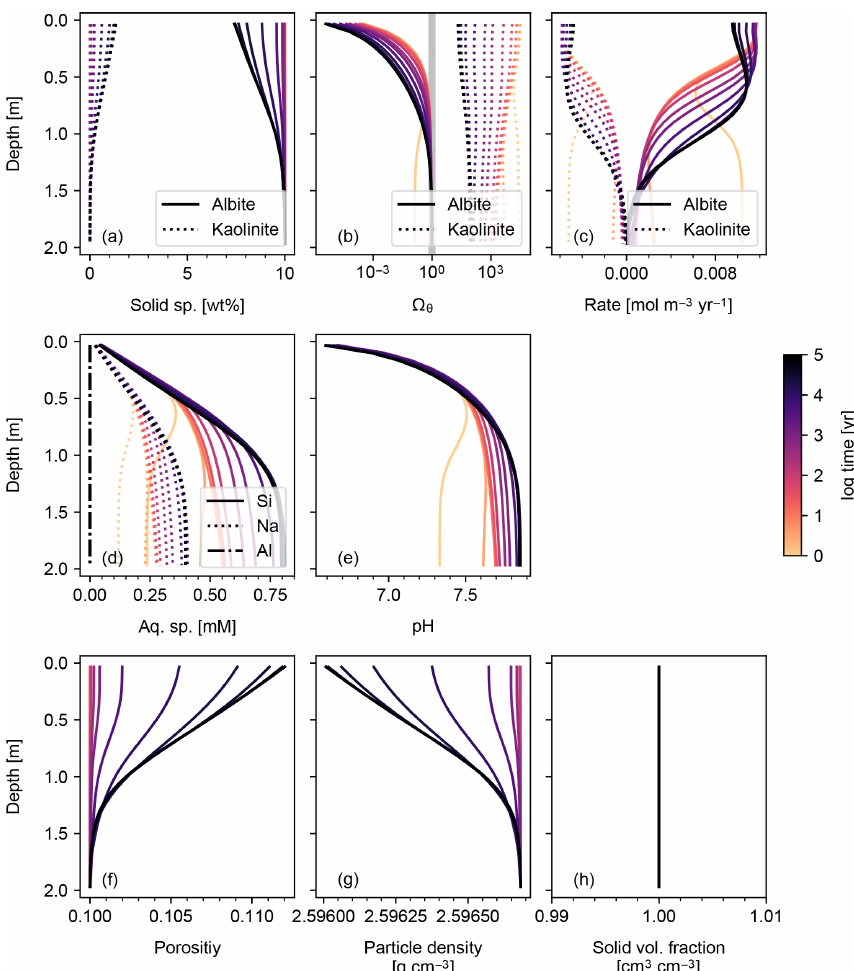
Figure 1. Simulation of abiotic weathering of albite. Soil concentrations, saturation states and dissolution/precipitation rates of solid species are plotted in panels (a) – (c) , respectively; porewater concentrations of aqueous species and pH in (d) and (e) , respectively; soil porosity and particle density in (f) and (g) , respectively; ratio of total volume of solid species against solid space specified with porosity in (h) . See Table 7 for the details on the boundary conditions of the